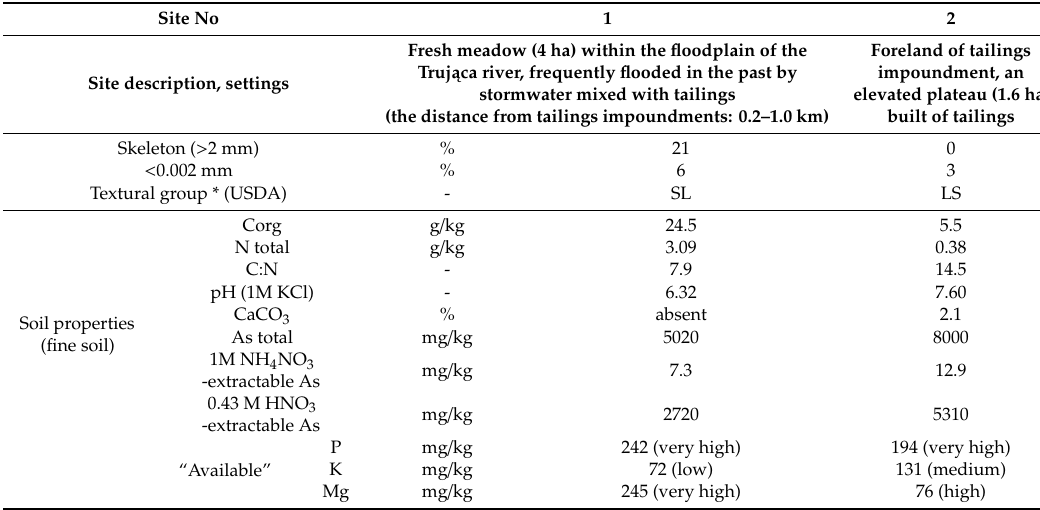
Table 1. Basic soil